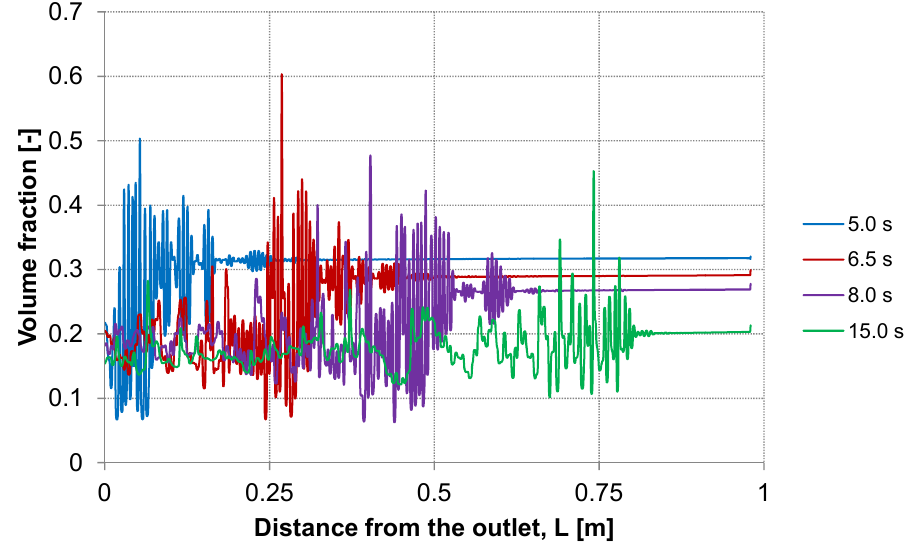
Figure 10. Particle distribution at control line E with backwashing flux of 300 L m − 2 h − 1 , (deposited layer as initial distribution, particle diameter of 7